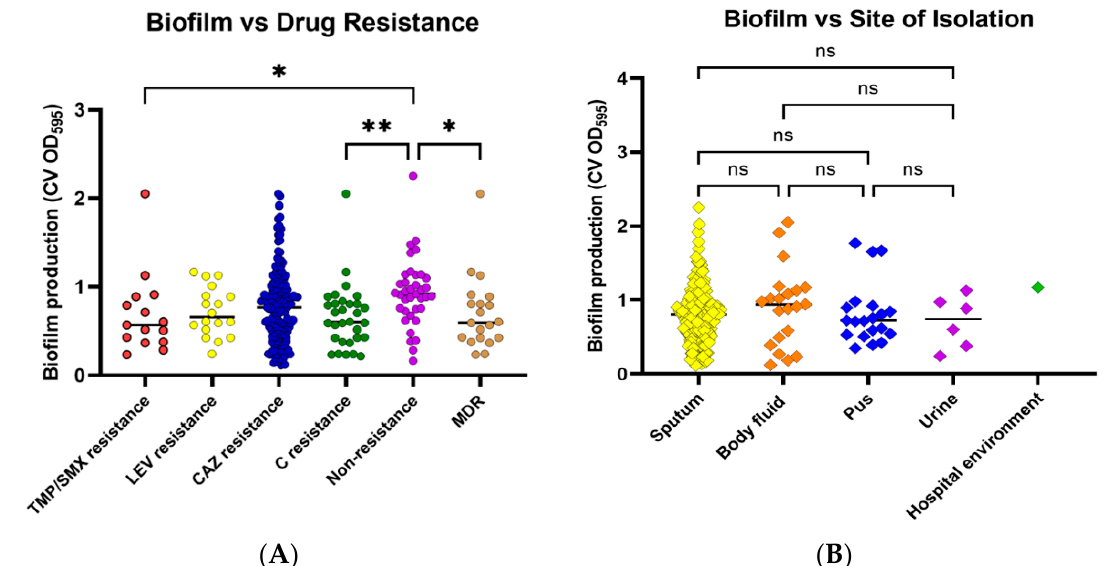
Figure 1. Biofilm formation by S. maltophilia isolates. Biofilm formation was evaluated using a crystal violet assay by measuring crystal violet absorbance (CV OD) at 595 nm. Biofilm formation capabilities were investigated among various antibiotic-resistant groups ( A ) and sites of isolation ( B ). Antibiotic-resistant groups included trimethoprim/sulfamethoxazole (TMP/SMX) resistance, levofloxacin (LEV) resistance, ceftazidime (CAZ) resistance, chloramphenicol (C) resistance, nonresistance, and multidrug resistance (MDR). Each symbol showed the mean OD 595 value with the median line of each distribution. Statistical significance at Fisher’s exact test: * p < 0.05, ** p < 0.01. ns = non-significant. Table 4. Virulence phenotypes of S. maltophilia isolates stratified on the different resistance groups.